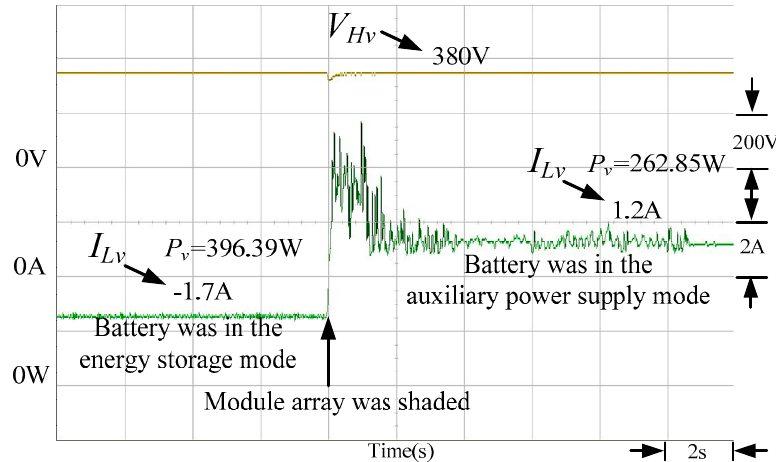
Figure 17. Measured results of the battery under energy storage mode and auxiliary power supply mode.